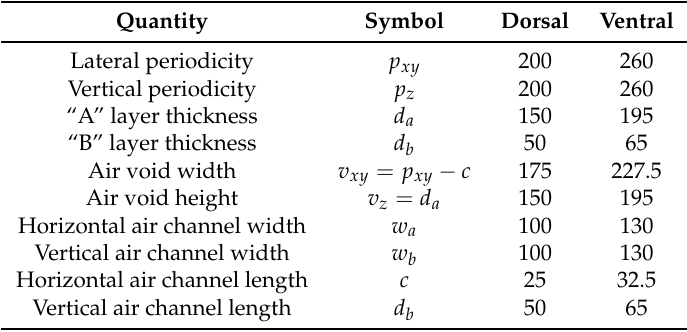
Table 1. Dimensions of the 3D model. All sizes are in